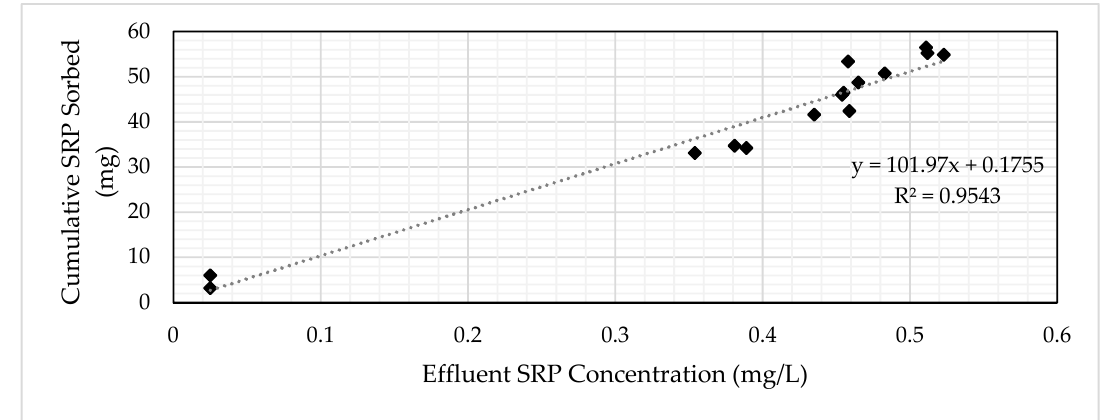
Figure 9. SRP concentration vs. cumulative SRP-sorbed graph for GNEM.